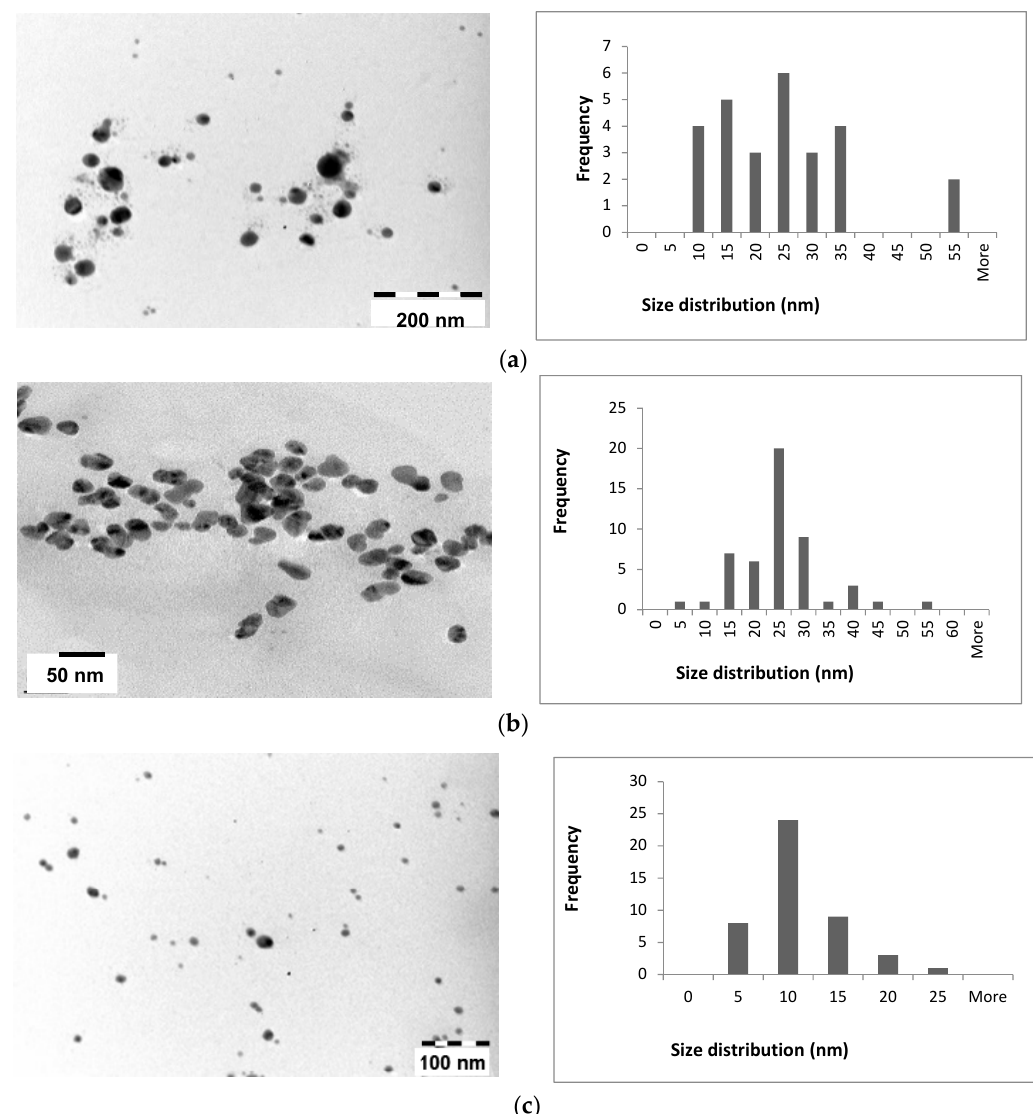
Figure 7. TEM images and NP size distributions obtained for ( a ) AC-AgNPs; ( b ) AR-AgNPs and ( c ) Fv-AgNPs. AC: Aqueous extract subjected to organic solvent partitioning. AR: simple aqueous extraction. Table 2. Ag NP data obtained including mean AuNP sizes as determined by TEM, XRD and DLS, as well as Zeta potential measurements and supernatant metal salt